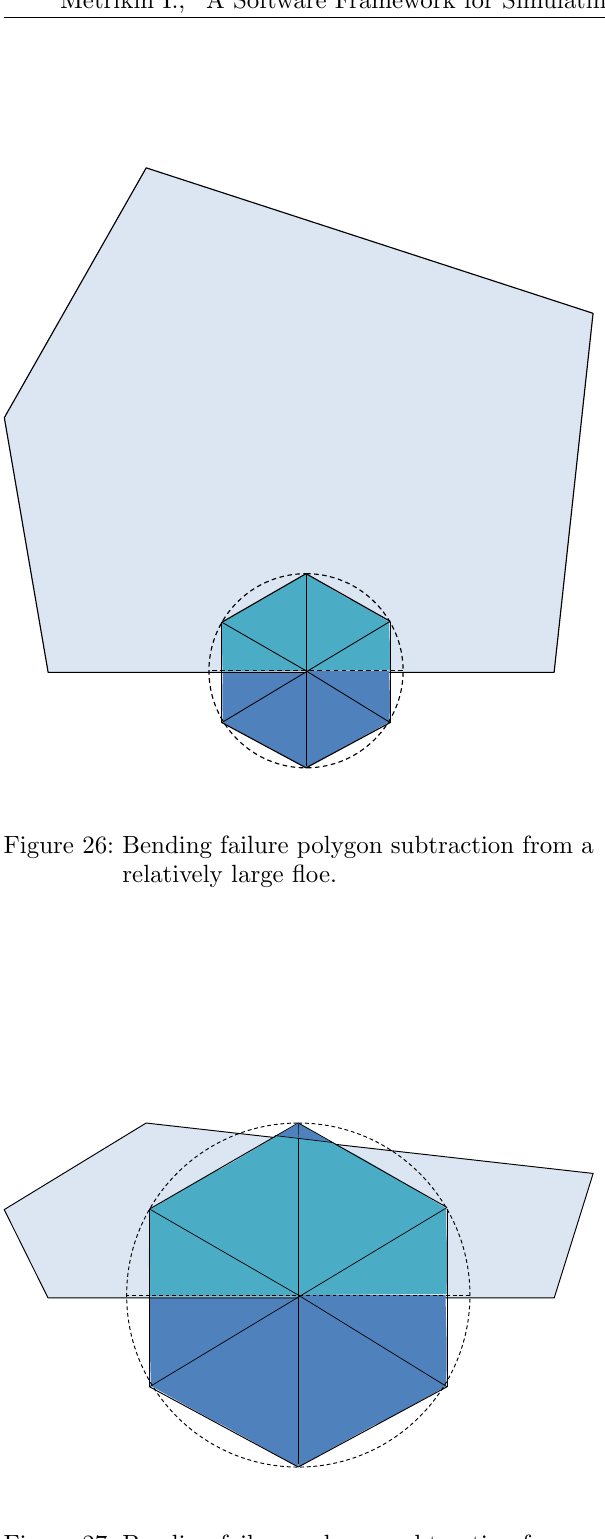
Figure 27: Bending failure polygon subtraction from a relatively small